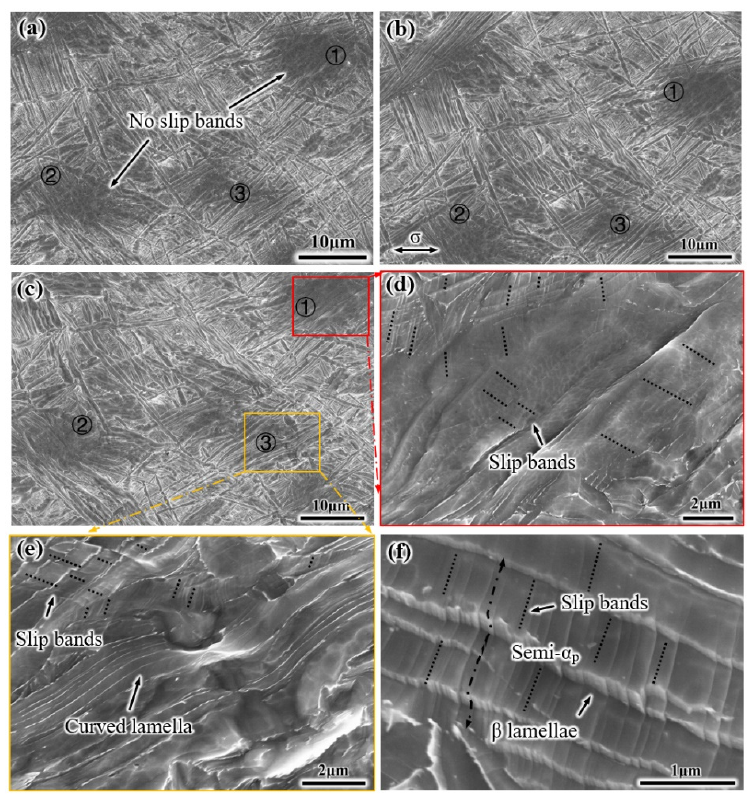
Figure 9. Microstructural characteristics of the S-EM under tensile deformation at different strain: ( a ) 6%, ( b ) 8.3%, and ( c – f ) 14%. (The different semi-equiaxed α p phases in the S-EM are marked with ① , ② and ③ ).